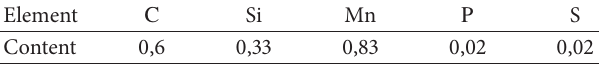
Figure 1: Microstructural image demonstrated the low temperature ductile-brittle transition in structural steel 09G2. Table 1: Chemical composition of steel, mass%. Figure 2: The deformation curves for tensile test.